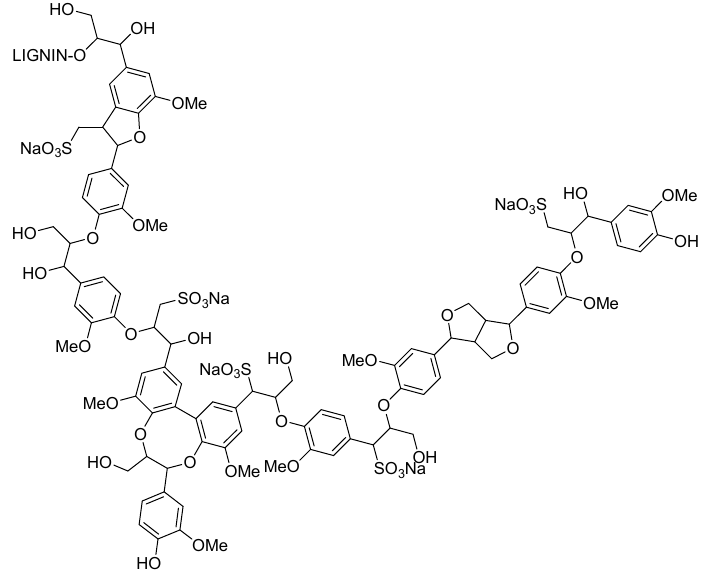
Figure 1. Generic structure of softwood lignosulfonate ( SLS ) oligomers used before in softwood lignosulfonate-based microcapsules ( SLS-MC )-generation [12].